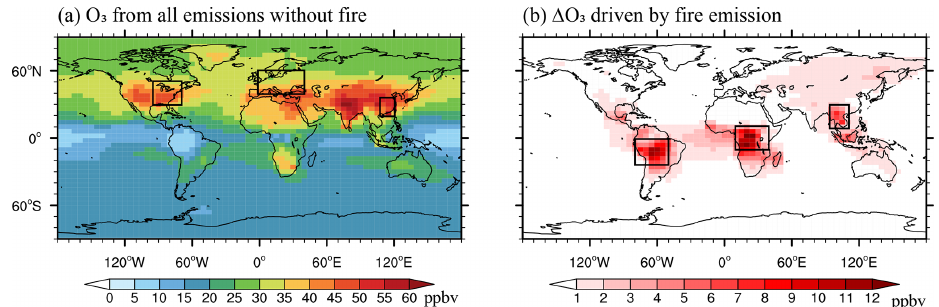
Figure 3. Annual surface [O 3 ] from (a) non-fire sources and (b) fire sources alone. The six subregions are marked with black boxes: eastern US (EUS; 30–50 ◦ N, 95–70 ◦ W), western Europe (WEU; 40–60 ◦ N, 0–40 ◦ E), eastern China (ECH; 20–35 ◦ N, 108–120 ◦ E), Amazon (AMZ; 25 ◦ S–0 ◦ , 80–50 ◦ W), central Africa (CAF; 10 ◦ S–10 ◦ N, 10–40 ◦ E), and southern Asia (SAS; 10–30 ◦ N, 95–110 ◦